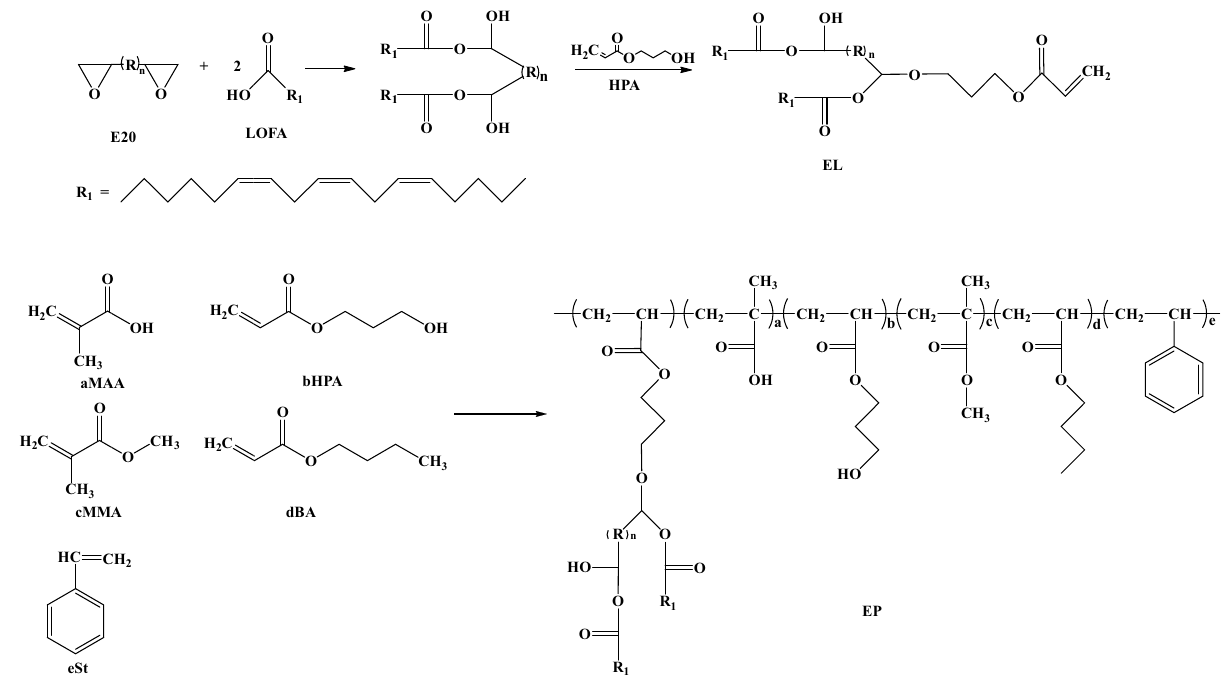
Scheme A1: Reaction equation.